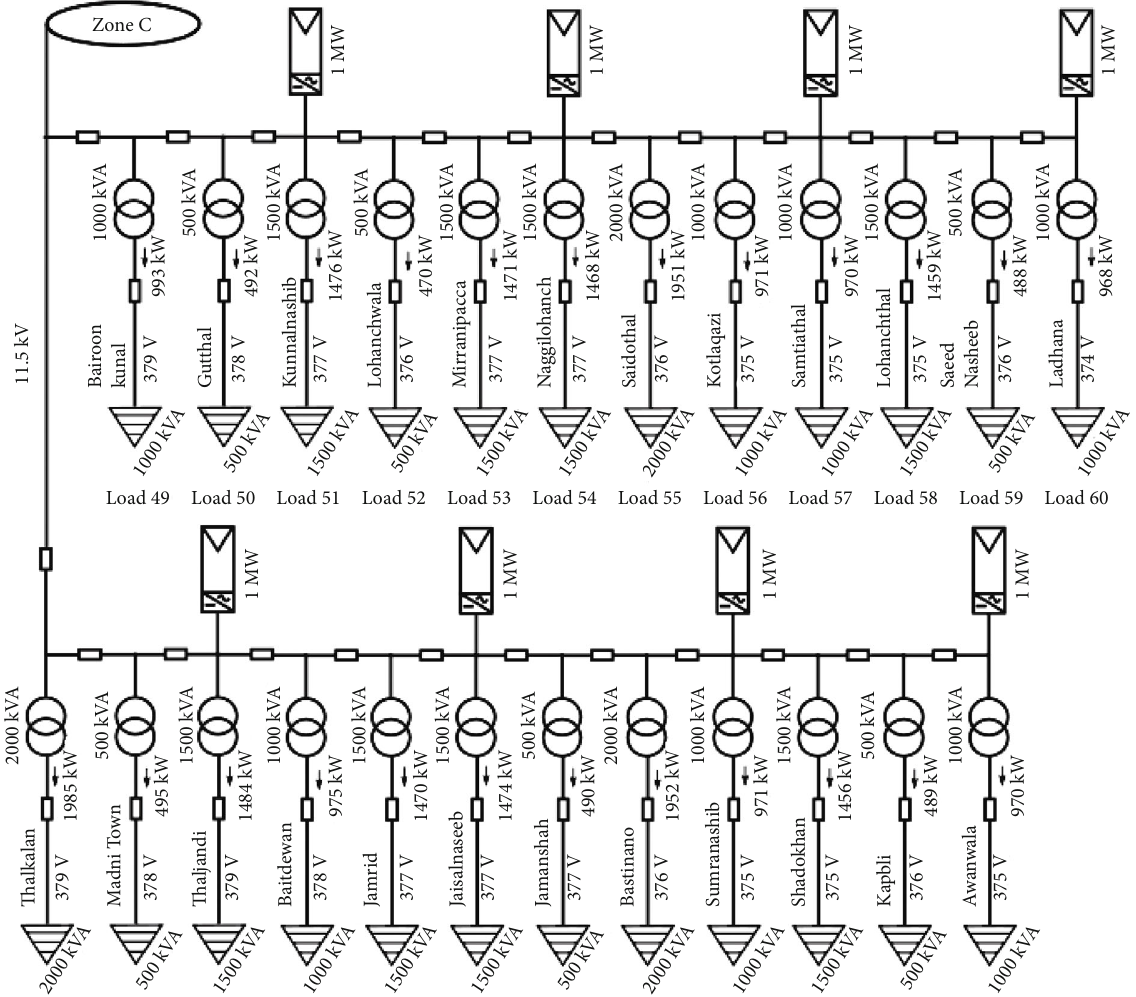
Figure 14: Implementation of zone C of the new system on ETAP. When transformers of proper ratings are used, losses reduce to a great extent. In the old system, transformer losses were reaching 30 kW and they reach up to 6.5 kW for the new system. The graph of transformer losses is shown in Figure 22(a). Line losses are reduced when DG is injected and by replacing lines of proper ratings. Twelve distribution lines are overloaded and are replaced with 500 MW lines in the system. In zone C too, line losses are approaching 120 kW which reduces to around 6 kW for the new system. A graph is shown in Figure 22(b) showing the line losses in the exist- ing and updated systems. The power factor of the load is improved when DG is injected at the load side. Again for zone C, the new power factor is nearly unity. For the existing system, the power factor reduced to as low as 0.68 which improved after the DG injection. The graph between old Figure 15: Actual and new rating of transformers in zone and new power factors is shown in Figure 23(a). The voltage pro fi le is also improved as a result of DG injection. For the old system, the voltage level varied between